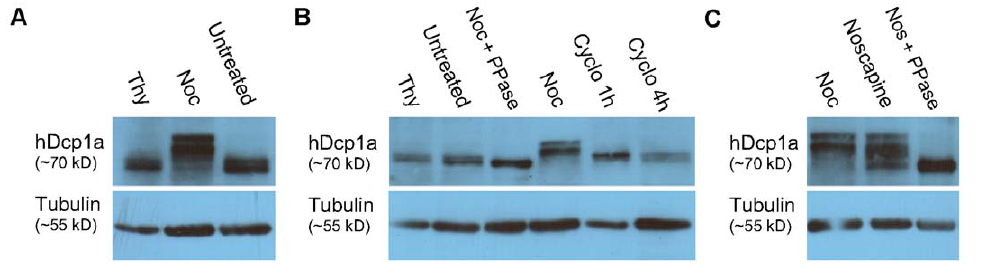
Figure 4. Dcp1a is hyper-phosphorylated during cell division. Western blot analysis of (A) endogenous hDcp1a protein in U2OS cell extracts during interphase (untreated), metaphase (nocodazole block, Noc) and at G1/S (thymidine block, Thy), showed the appearance of slower migrating Dcp1a bands in metaphase cells. (B) Treatment of U2OS protein extracts from metaphase cells with a phosphatase (Noc + PPase) caused a reduction in the molecular weight of hDcp1a, compared to untreated, G1/S blocked (Thy), and metaphase blocked cells (Noc). This demonstrated that Dcp1a is hyper-phosphorylated during mitosis. Treatment with cycloheximide (Cyclo) for 1 or 4 hrs did not change the mobility of hDcp1a indicating that hyper-phosporylation is cell cycle dependent. (C) Shift in mobility due to hyper-phosphorylation in mitotic cells is seen using two different cell cycle blockers, nocodazole (Noc) and noscapine. Similarly, phosphatase treatment (Nos + PPase) caused a reduction in the molecular weight of Dcp1a from noscapine treated cells. Tubulin was used as a loading